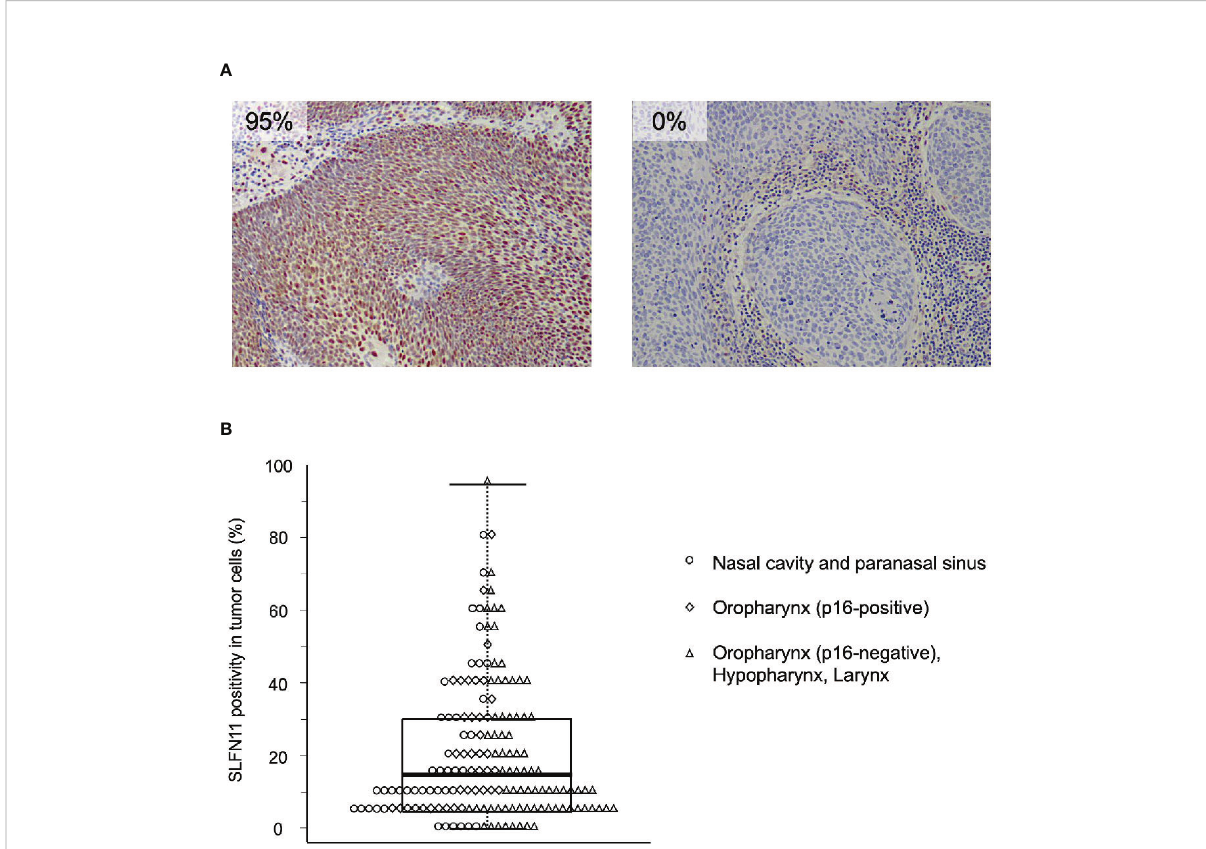
FIGURE 1 Immunohistochemical examination of Schlafen family member 11 (SLFN11) in head and neck squamous cell carcinoma (HNSCC). (A) Representative images of immunohistochemical staining of SLFN11 in HNSCC. Formalin- fi xed, paraf fi n-embedded tissue specimens of tumor biopsy samples before chemoradiotherapy (CRT) were subjected to immunohistochemistry using an anti-SLFN11 antibody. Left, an example of an SLFN11-positive case, in which most tumor cell nuclei were positive for SLFN11 (SLFN11: 95%). Right, an example of an SLFN11-negative case, in which no SLFN11- positive cells were observed in the tumor area (SLFN11: 0%). Stromal cell staining was not counted. (B) Dot and box-and-whisker plots showing the distribution of the percentage of SLFN11 positivity. Each dot represents the value for an individual case, whose primary site is indicated on the right. The highest and lowest boundaries of the box represent the 25 th and 75 th percentiles, respectively, and the whiskers above and below the box designate the maximum and minimum values, respectively. The line within the box indicates the median